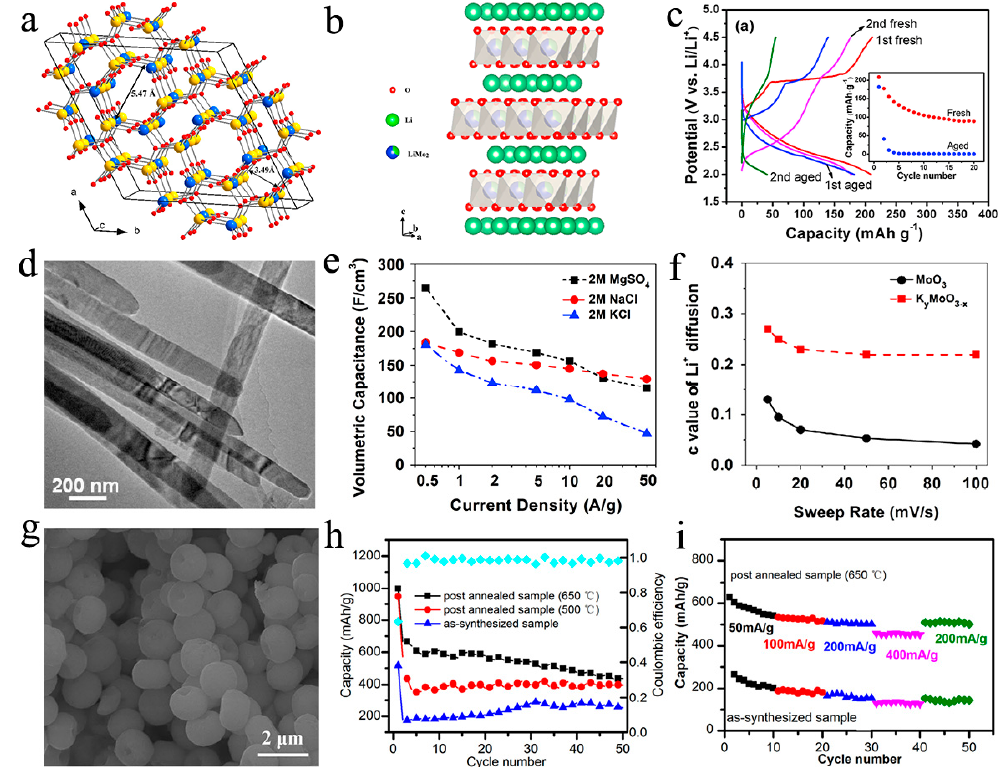
Figure 2. ( a ) Crystal structure of the rhombohedral modification of Li 2 MoO 4 . Blue and yellow spheres represent Mo and Li ions, respectively. Narrow and wide channels along the c-axis feature 4-member rings and 6-member rings, respectively. Reproduced with permission. [30] Copyright 2015, American Chemical Society. ( b ) Lattice structure of Li 2 MoO 3 . ( c ) Charge and discharge potential curves of the fresh and aged Li 2 MoO 3 ; the inset is for their cycling performances. Reproduced with permission. [31] Copyright 2014, Elsevier B. V. ( d ) Low-resolution TEM image of K y MoO 3 − x nanobelts. ( e ) Volumetric capacitance and current density for K y MoO 3-x in different electrolytes. ( f ) Numbers of Li + inserted in the tunneled MoO 3 and K y MoO 3 − x (c value of Li + diffusion). Reproduced with permission. [16] Copyright 2015, Elsevier B. V. ( g ) Morphological of as-synthesized CaMoO 4 microspheres by reaction time of 0.5 h. ( h ) Cycling performance of the CaMoO 4 microspheres before and after being heat-treated at different temperatures at current densities of 200 mA g − 1 . ( i ) Rate performance of CaMoO 4 microspheres before and after calcination at 650 ◦ C. Reproduced with permission. [32] Copyright 2018, Springer